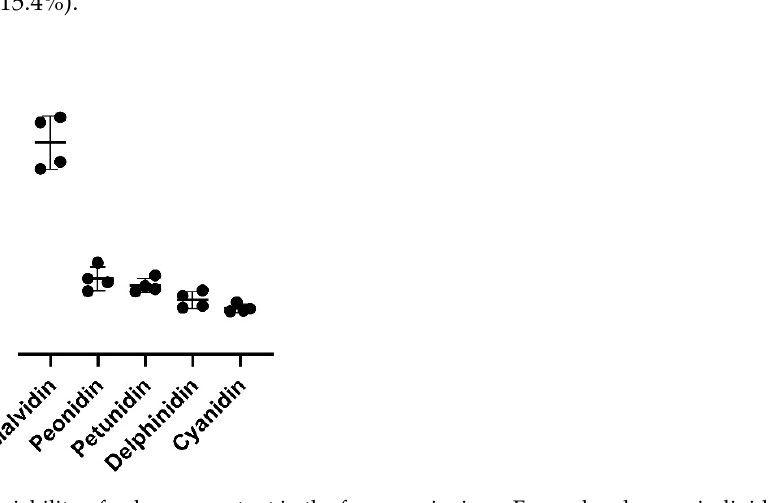
Figure 6. Relative percentages of anthocyanin derivatives (glucosides, acetyl glucosides, couma- royl/caffeoyl glucosides, pyranoanthocyanins) found in the four samples (A, B, C, D). Data are re- ported as mean ± SD.